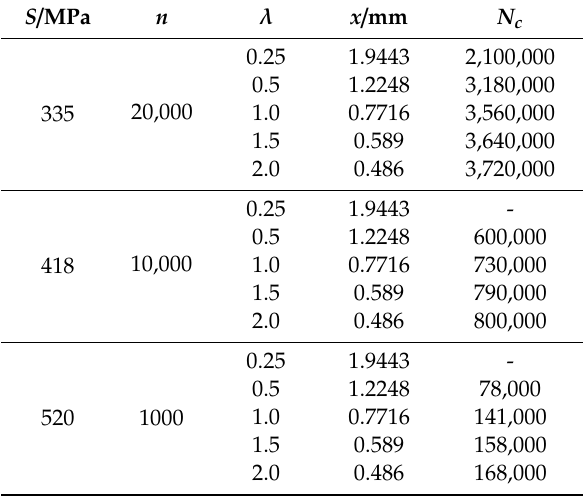
Table 3. Fatigue life of pre-corroded steel wire with a regular corrosion pit ( η = 2.5% ).